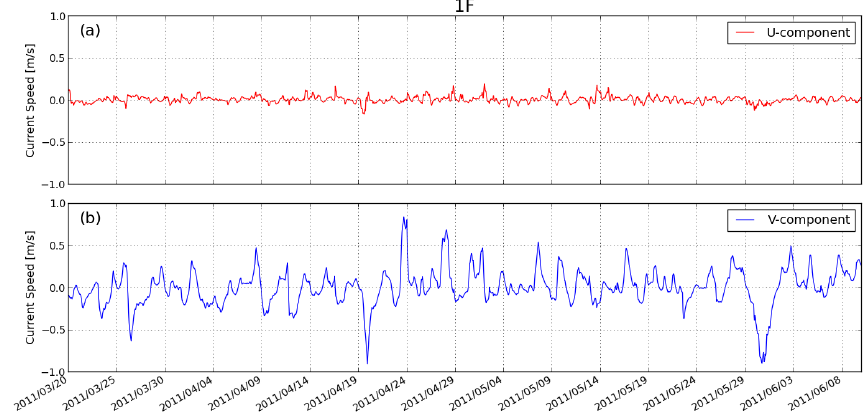
Fig. 2. Simulated current vectors (ms − 1 ) adjacent to the 1F NPP. (a) The U-component is the net east-west speed toward the east. (b) The V-component is the net north-south speed toward the north.